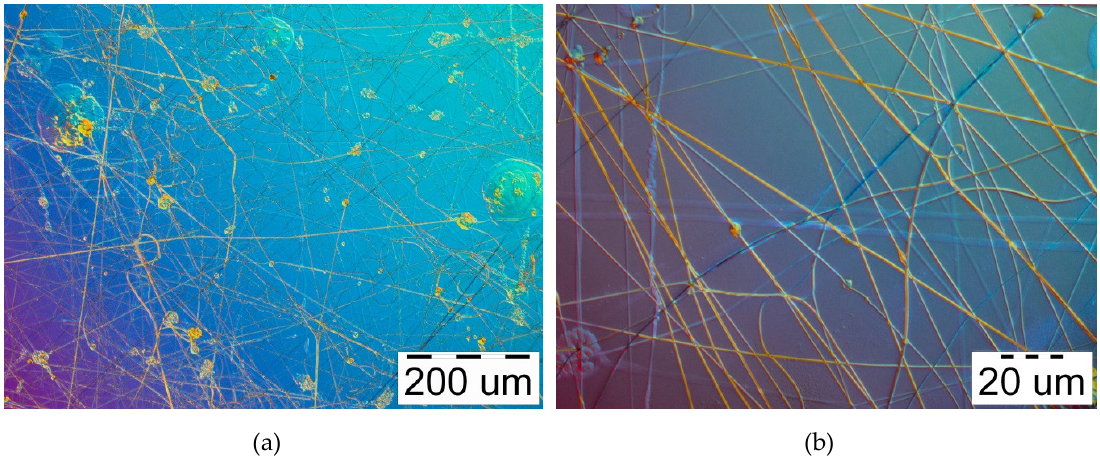
Figure 3. Microphotographs of curcumin/usnic acid-loaded hyaluronic acid fibers electrospun from the polymer solutions under 22 kV: ( a ) magnification 100×; ( b ) magnification 1000×.